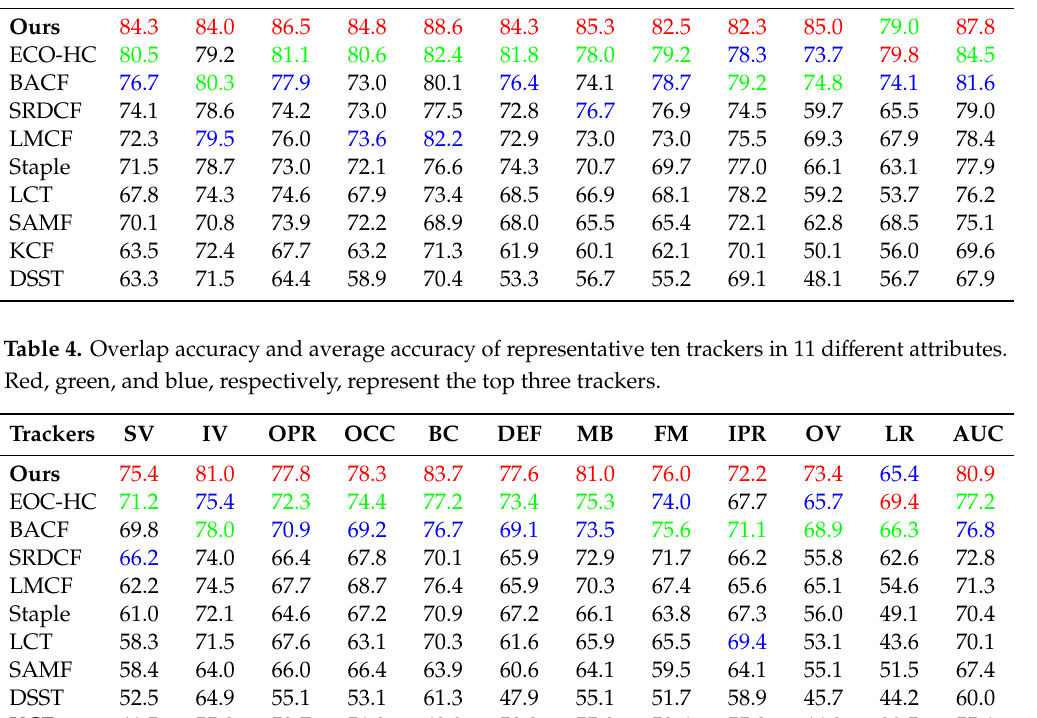
Table 3. Central position accuracy and average accuracy of representative ten trackers in 11 di ff erent attributes. Red, green, and blue, respectively, represent the top three trackers.